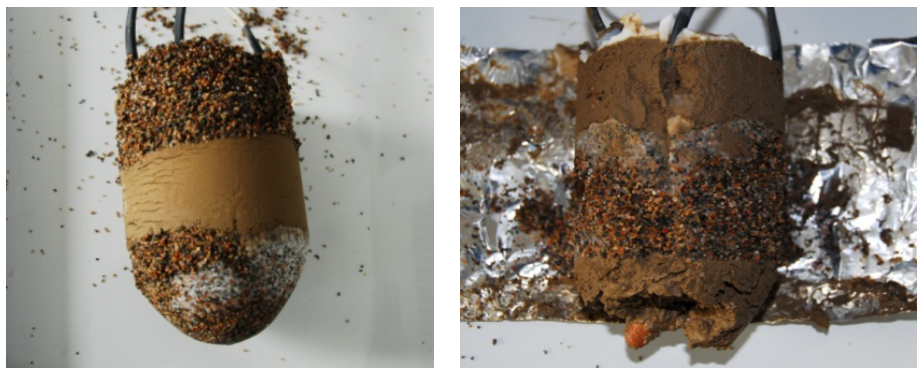
Figure 2. Photographs of hydrate configuration in different layered media (water conversion ratio in the left is 23.1% and that in the right is